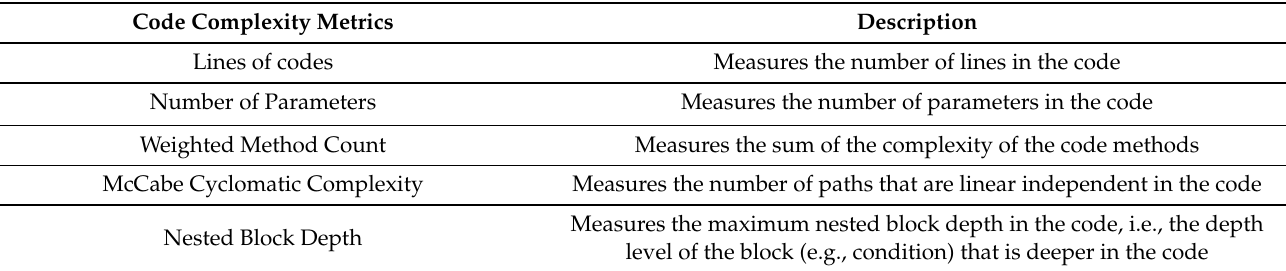
Table 1. Brief description of the code complexity software metrics used in the present work.